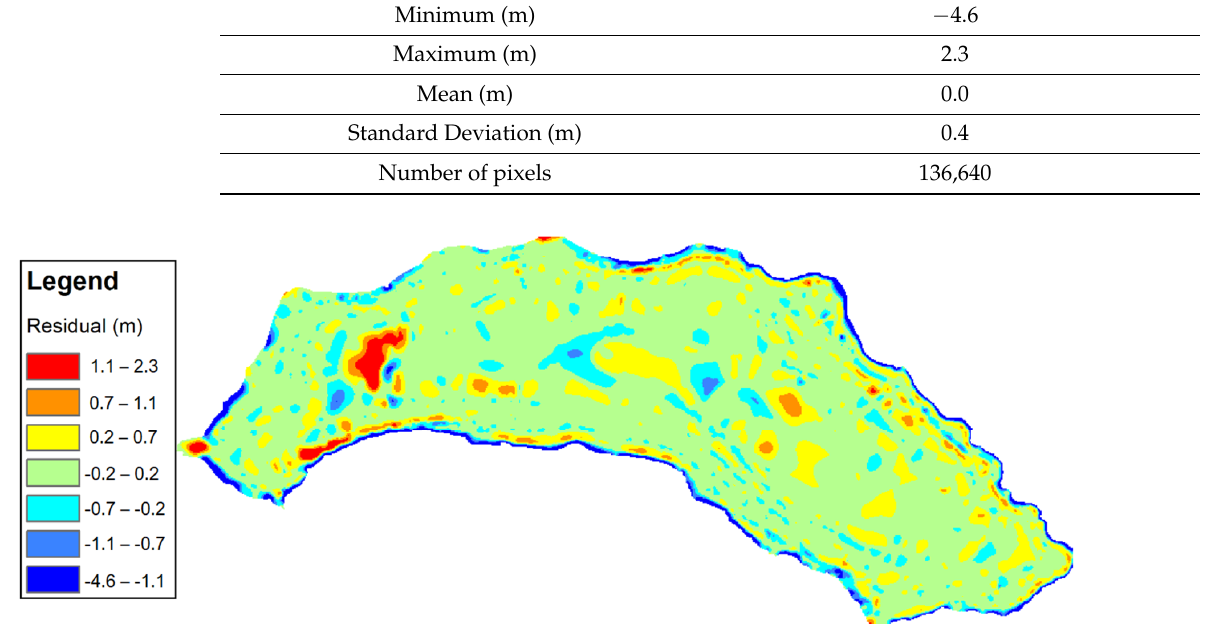
Figure 3. Estimation and spatial distribution of the Topo-to-Raster algorithm interpolation error.